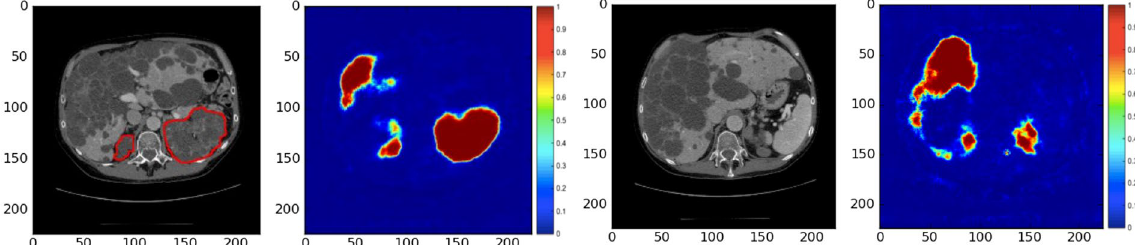
Figure 4. Mislabelled predictions by CNN. Left: Liver cysts predicted as foreground along with kidney region; Right: Cystic liver mislabelled as Kidney.